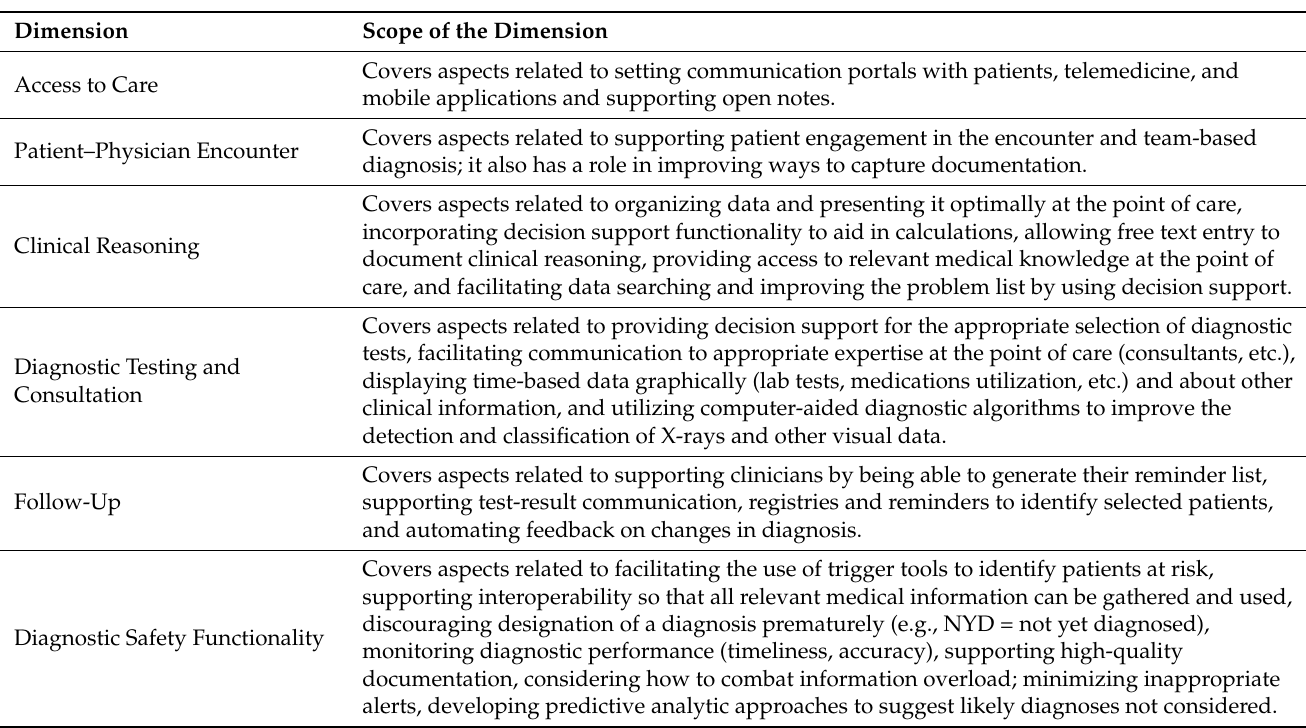
Table 1. The dimensions and attributes of the study.